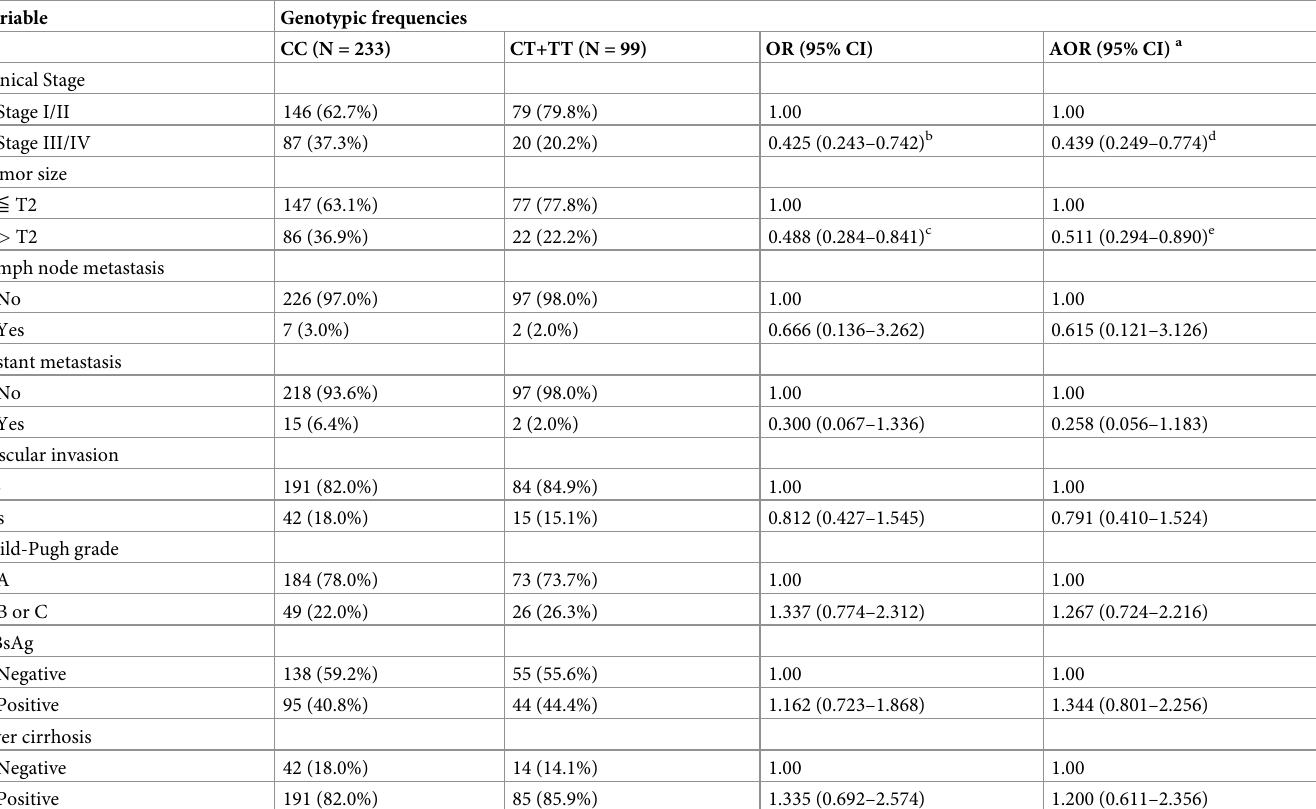
Table 4. Odds ratio (OR) and 95% confidence interval (CI) of clinical status and WISP1 rs16893344 genotypic frequencies in 332 HCC